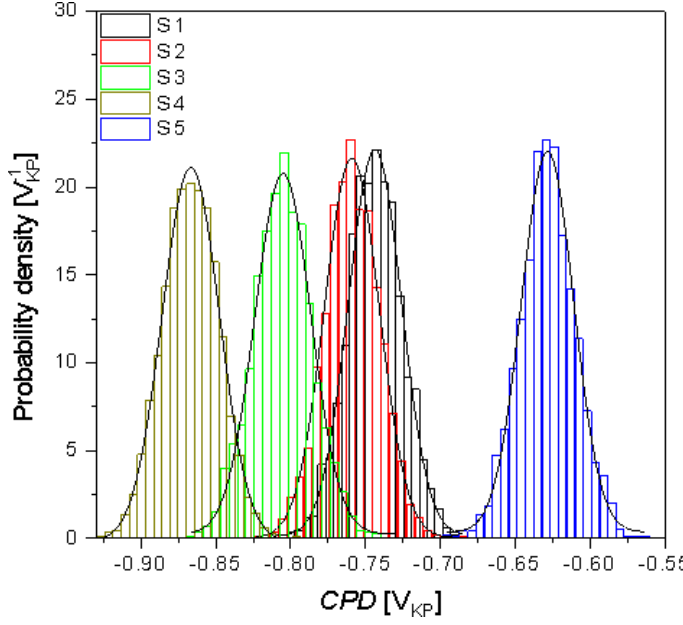
Figure 12. The CPD maps determined for the AISI 1010 carbon steel after the experiment in sulfolane at 95  C and etching ( a ); the experiment in sulfolane with the addition of 1 vol.% of water at 95  C and etching ( b ); the experiment in sulfolane with the addition of 2 vol.% of water at 95  C and etching ( c ); the experiment in sulfolane with the addition of 3 vol.% of water at 95  C and etching ( d ); after the experiment in sulfolane at 95  C without etching ( e ).